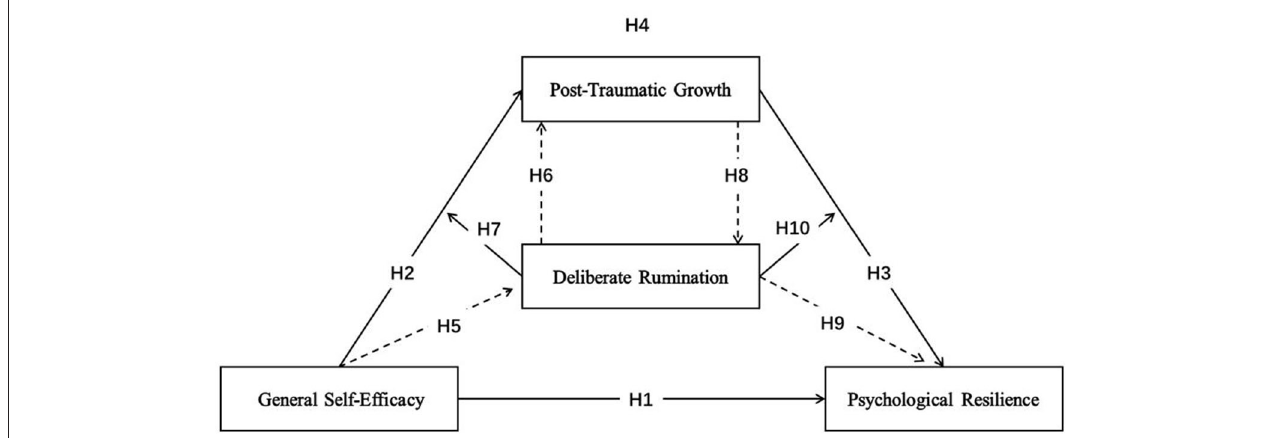
FIGURE 1 | The relationships examined in the study. The solid lines represent the direct assumptions of the moderated mediation model. Dotted lines represent supporting assumptions that support mediating and moderating effects.